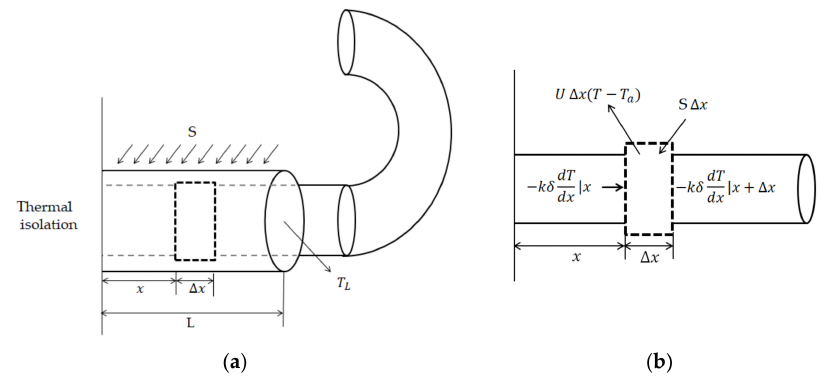
Figure 11. Analysis of thermal energy conservation in the microbody of the tube; ( a ) is L and the temperature of the endothermic coating at the junction of the straight tubes; ( b ) shows the microbody of the endothermic coating in the flow